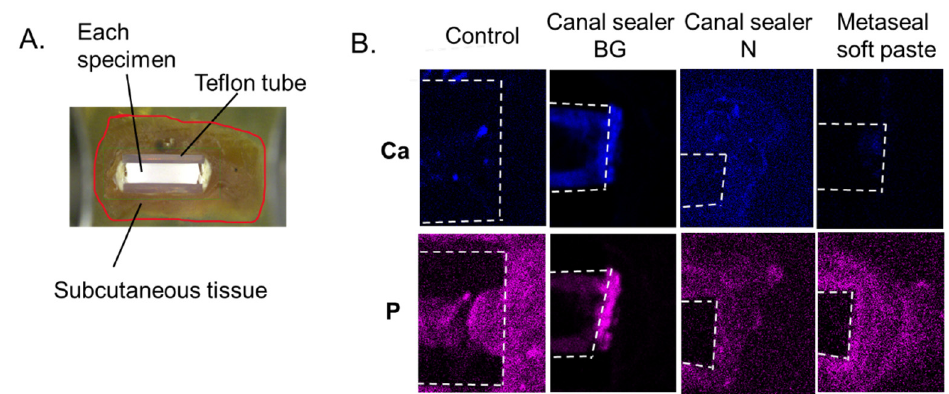
Figure 4. Micro-XRF analysis. The subcutaneous tissue around the RCO sealer was resin-embedded and analyzed using micro-XRF ( A ), (n = 3 per material). Red lines indicate the outline of the subcutaneous tissue. Elemental mapping of Ca and P obtained via micro-XRF is shown ( B ). The white dotted line shows the outline of the Teflon tube filled with the root canal filler. XRF: X-ray fluorescence spectroscopy . RCO: root canal obturation .